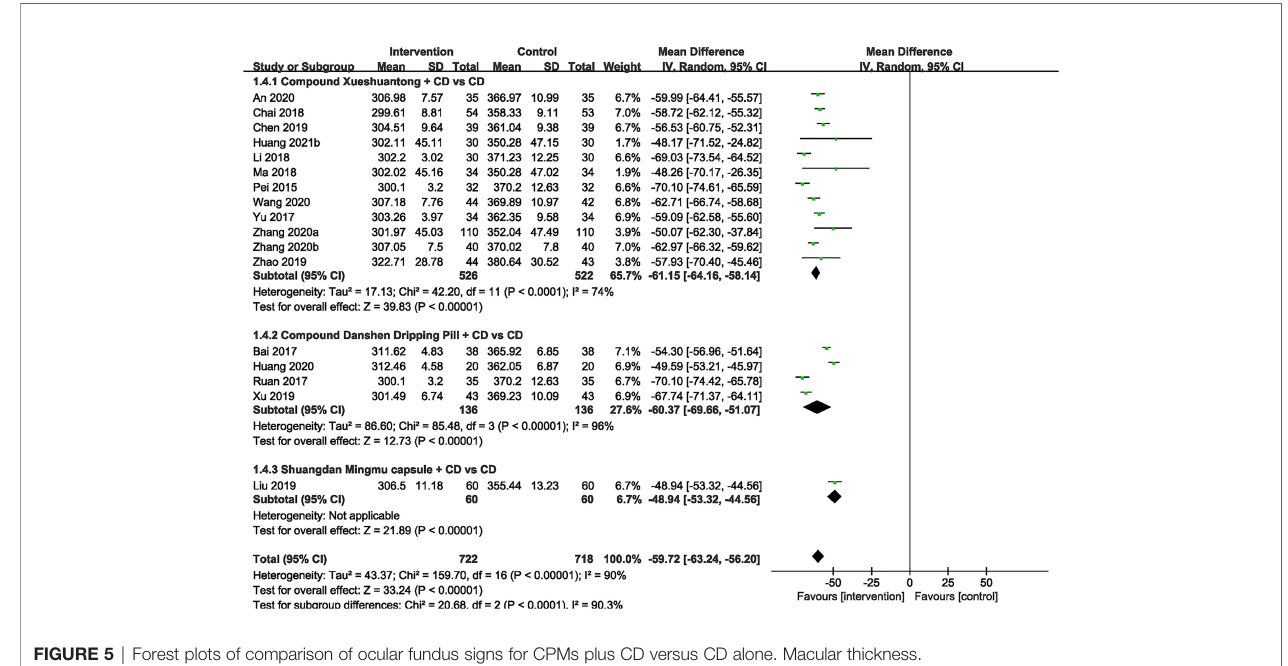
FIGURE 5 | Forest plots of comparison of ocular fundus signs for CPMs plus CD versus CD alone. Macular